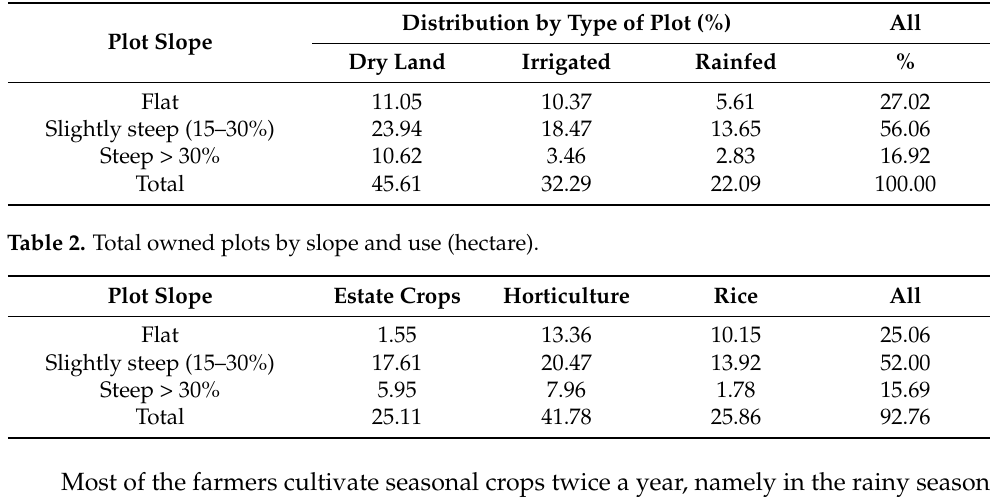
Table 1. Distribution of owned plots by type and slope. Distribution by Type of Plot (%) All Plot Slope Dry Land Irrigated Rainfed % Flat